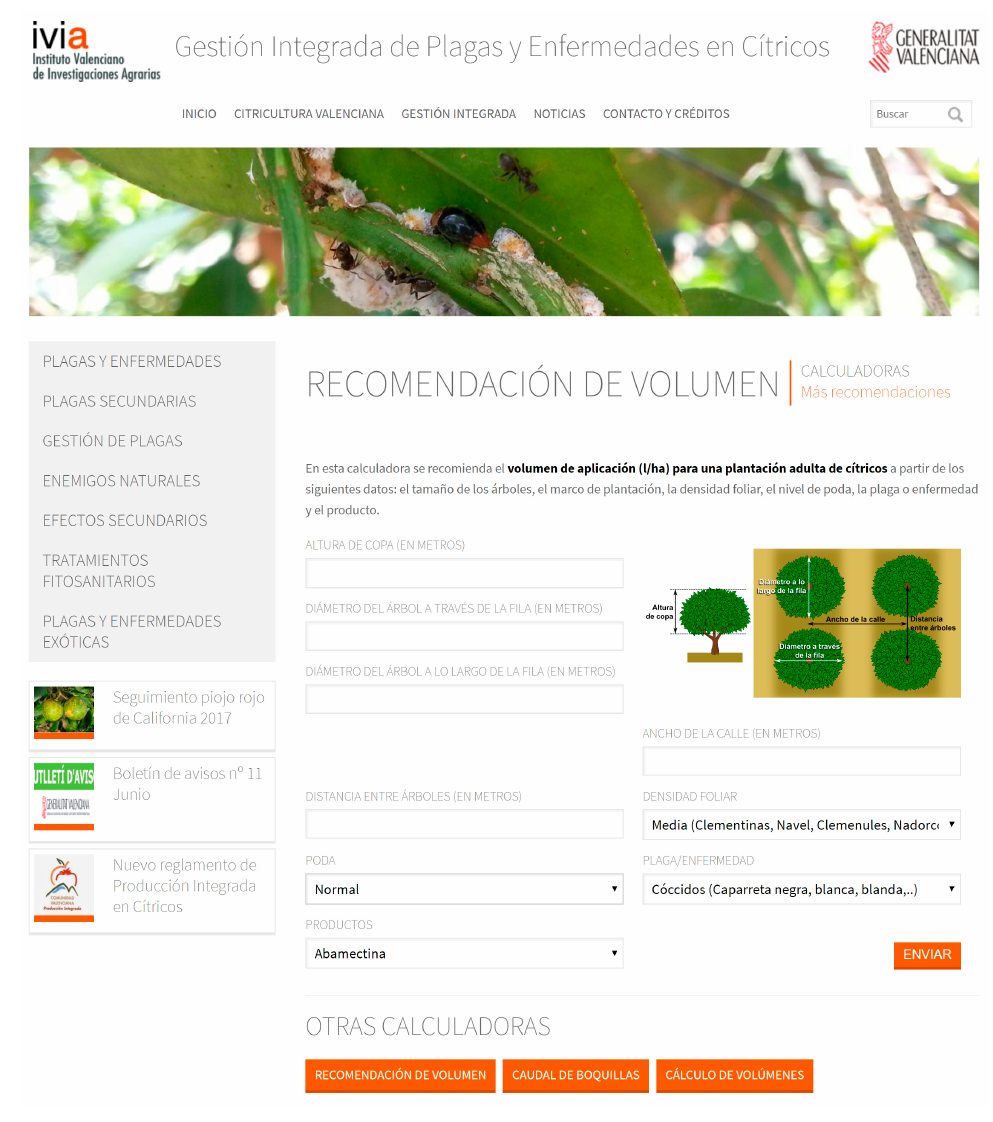
Figure 3. Interface of CitrusVol in the website [49].